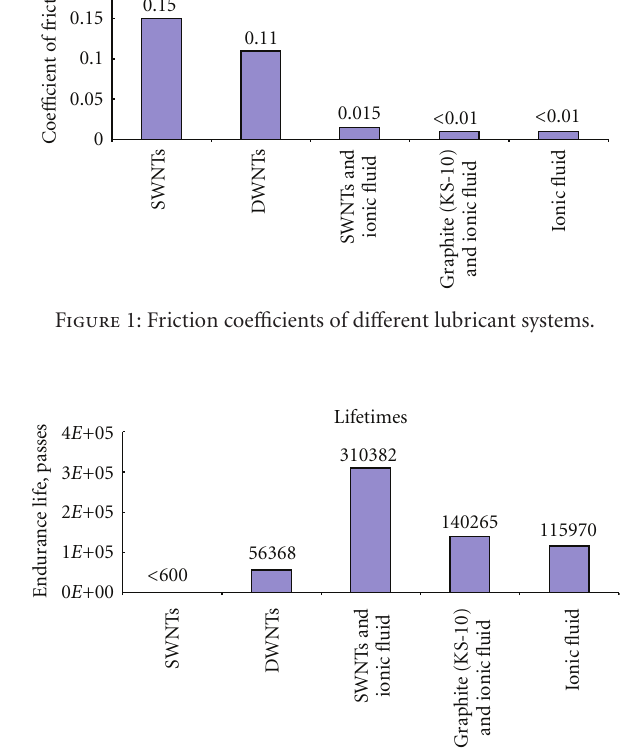
Figure 2: Lifetimes as measured by the number of cycles for the indicated lubricant